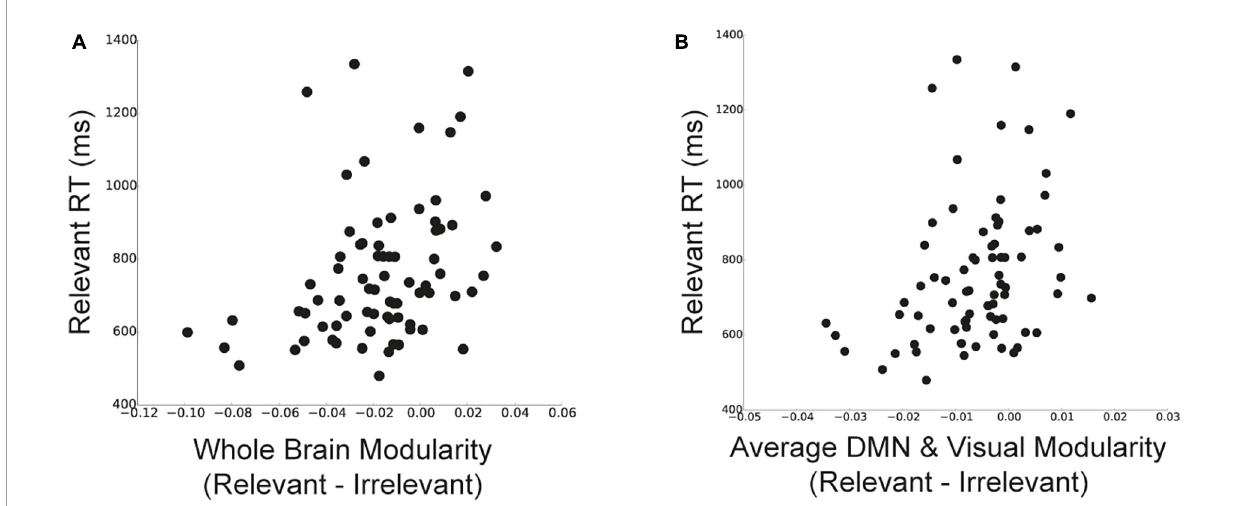
FIGURE5 Relationship between changes in network modularity and behavior. (A) Relationship between the difference in whole-brain modularity between relevant and irrelevant trials and RT for relevant stimuli. Lower modularity for relevant stimuli was related to faster performance on relevant trials. (B) Relationship between the difference in modularity of DMN and visual sub-network (average of the two sub-networks) between relevant and irrelevant trials and RT for relevant trials. Changes in modularity for DMN and visual sub-networks for relevant stimuli were related to faster performance on relevant trials. Data points represent individual